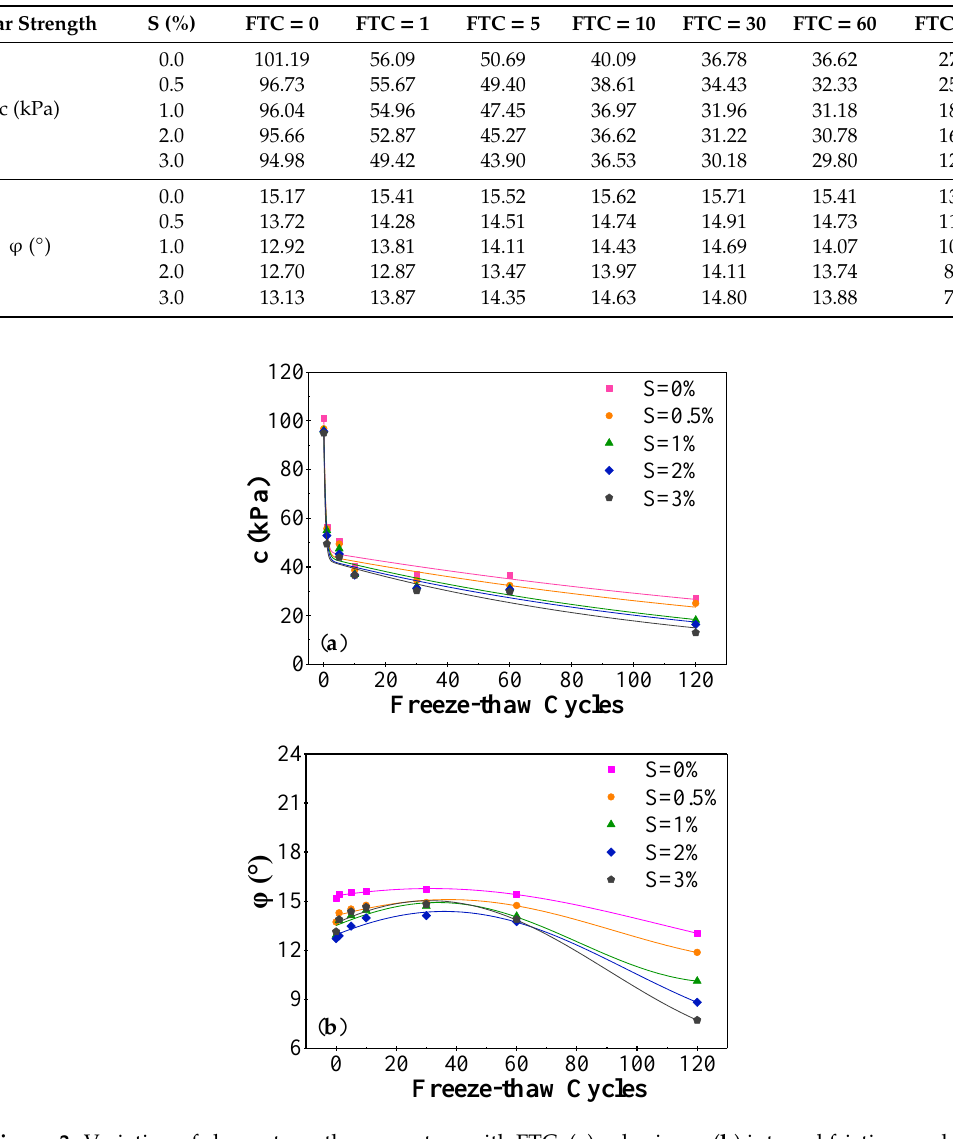
Figure 3. Variation of shear‐strength parameters with FTC: ( a ) cohesion c; ( b ) internal friction angle φ. C